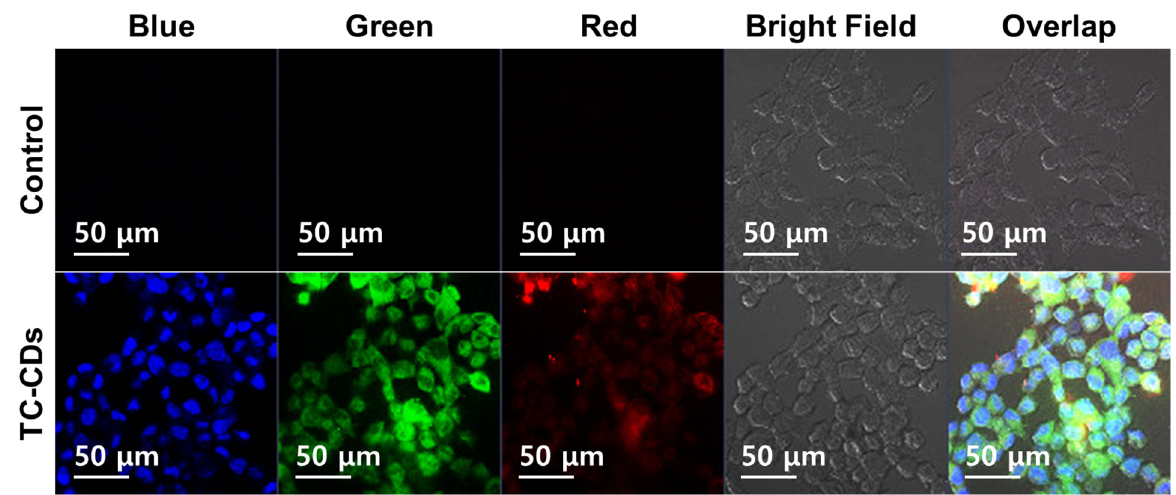
Figure 7. Confocal fluorescence images of human colon cancer (HCT-116) cells in the presence and absence of TC-CDs incubated at 24 h using different filters with excitation wavelengths of 405 (blue), 488 (green), and 555 nm (red) and in a bright field. Concentration of TC-CDs is 100 μ g mL − 1 .